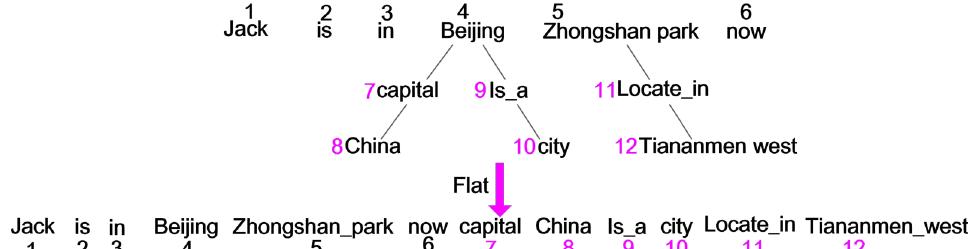
Figure 3. Flat of the sentence